Question: What does this figure show? Answer in one sentence.
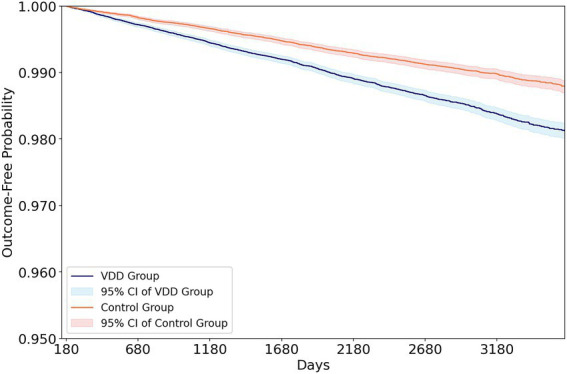
Answer: Kaplan–Meier curves for head and neck cancer–free survival over 10 years. The vitamin D deficiency group showed significantly lower cancer-free survival than the control group (log-rank p < 0.001). Shaded areas indicate 95% confidence intervals. Follow-up began 180 days after the index date and extended to 3,650 days.